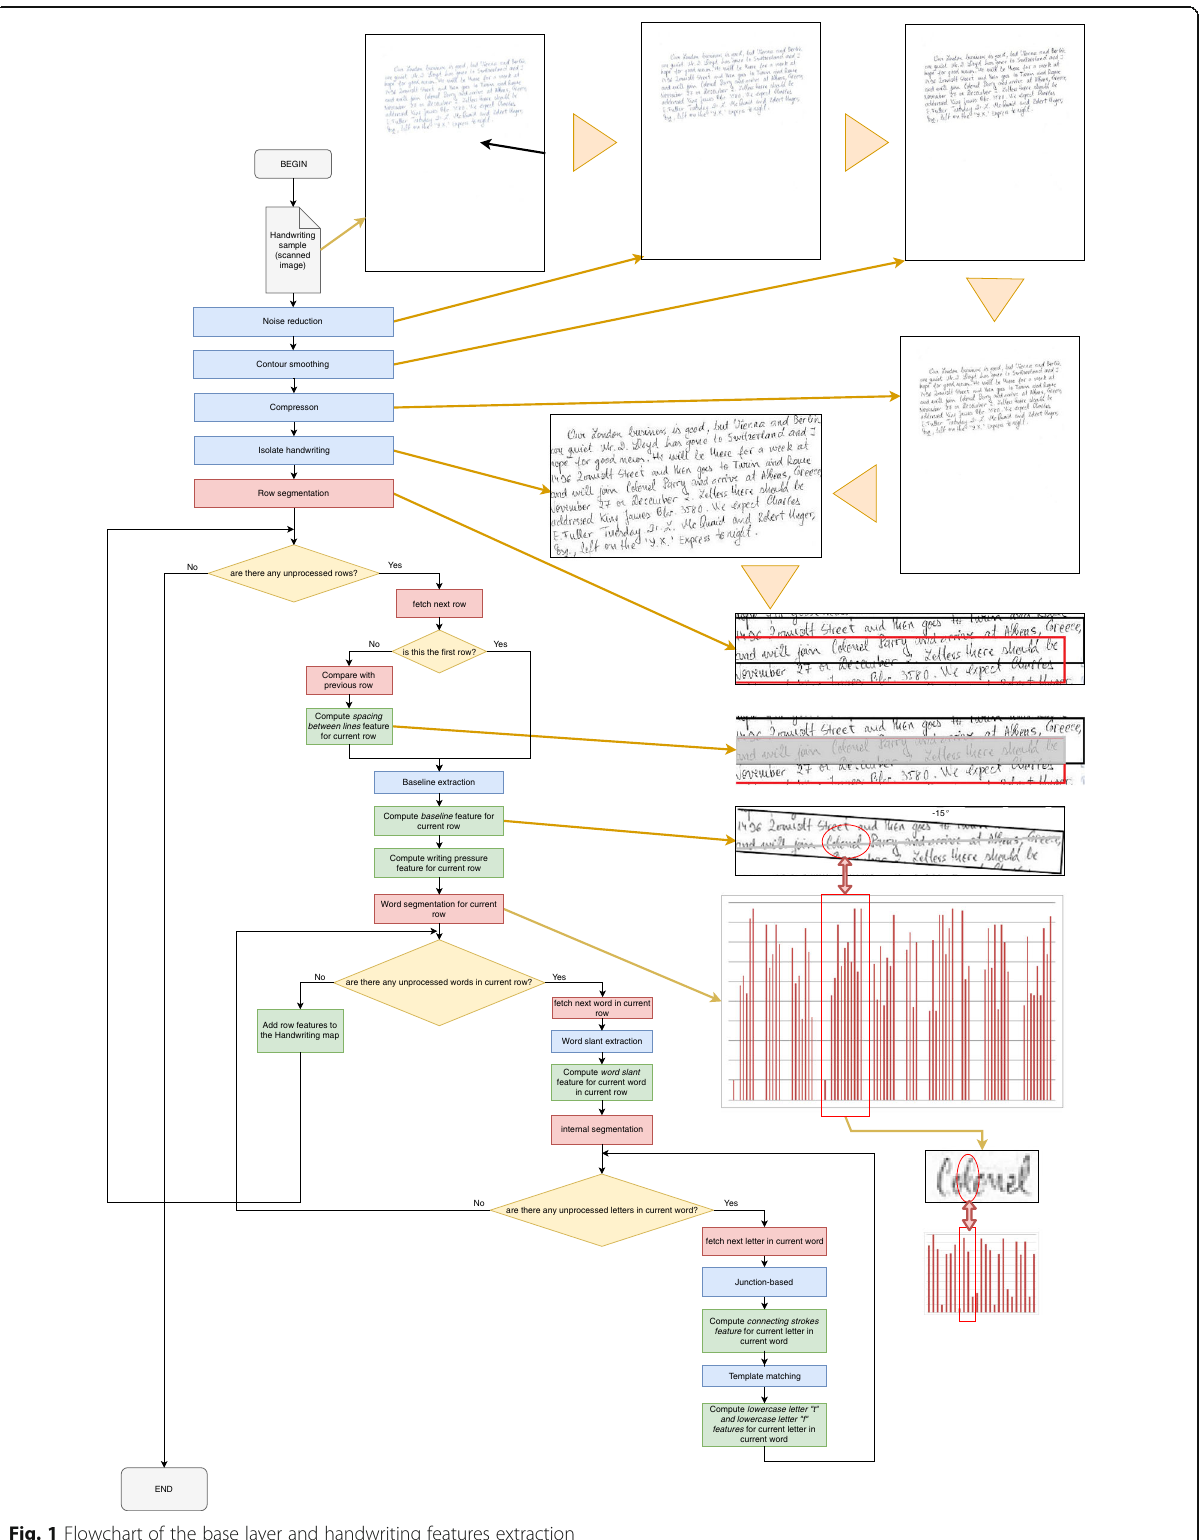
Fig. 1 Flowchart of the base layer and handwriting features